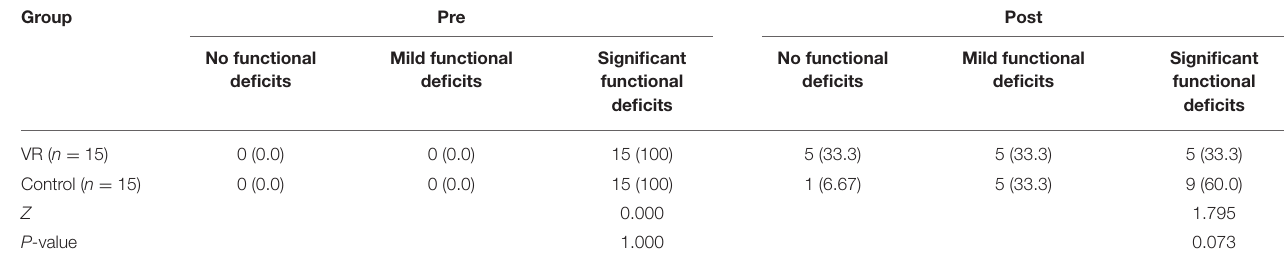
TABLE 5 | The functional grade in two groups during 3 months’ follow-up ( n ; %).